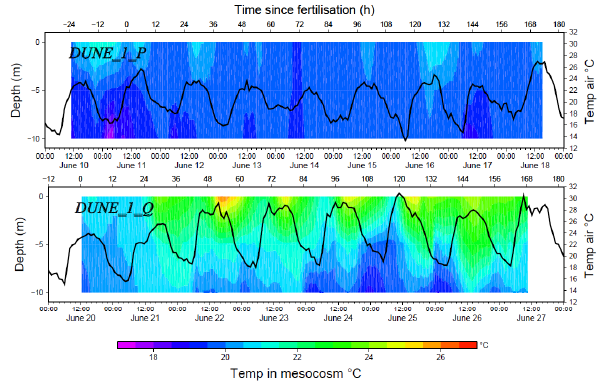
Figure 11 Fig. 11. Evolution of the seawater temperature profile from the Figure 12 surface down to 10m during the DUNE1 campaign. Top: P- Fig. 12. The different steps of the seeding: (a) on-site preparation experiment. Bottom: Q-experiment. The superimposed air temper- of the dust solution in ultra-pure water; (b) spraying the dust solu- ature (black line) indicates how the day/night cycle clearly impacted tion above the surface water of the mesocosm. The mixture is gen- the intensity of the stratification during the DUNE-Q experiment. tly pushed through the hose via a manually operated piston pump (photo: David Luquet,